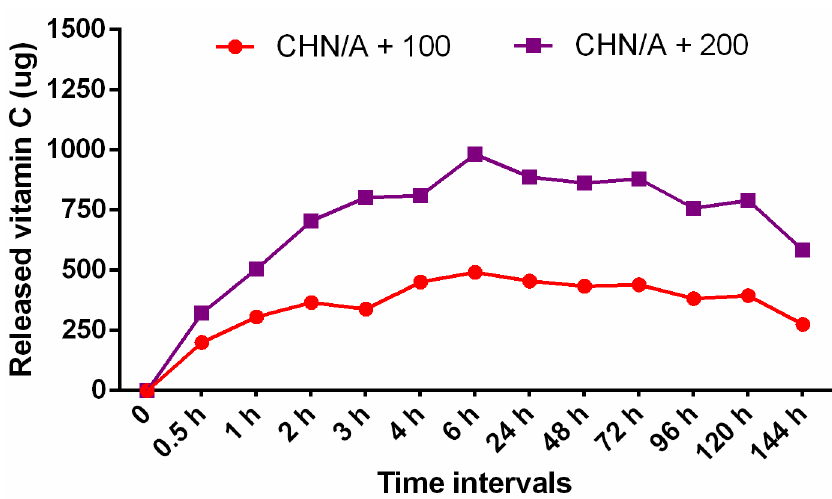
Figure 7. The profile of vitamin C release from CHN/A + 100 and CHN/A + 200 materials (CHN/A + 100 represents sample with the addition of 100 µg of vitamin C per 1 mL of biomaterial mass, CHN/A + 200 represents sample with the addition of 200 µg of vitamin C per 1 mL of biomaterial mass).